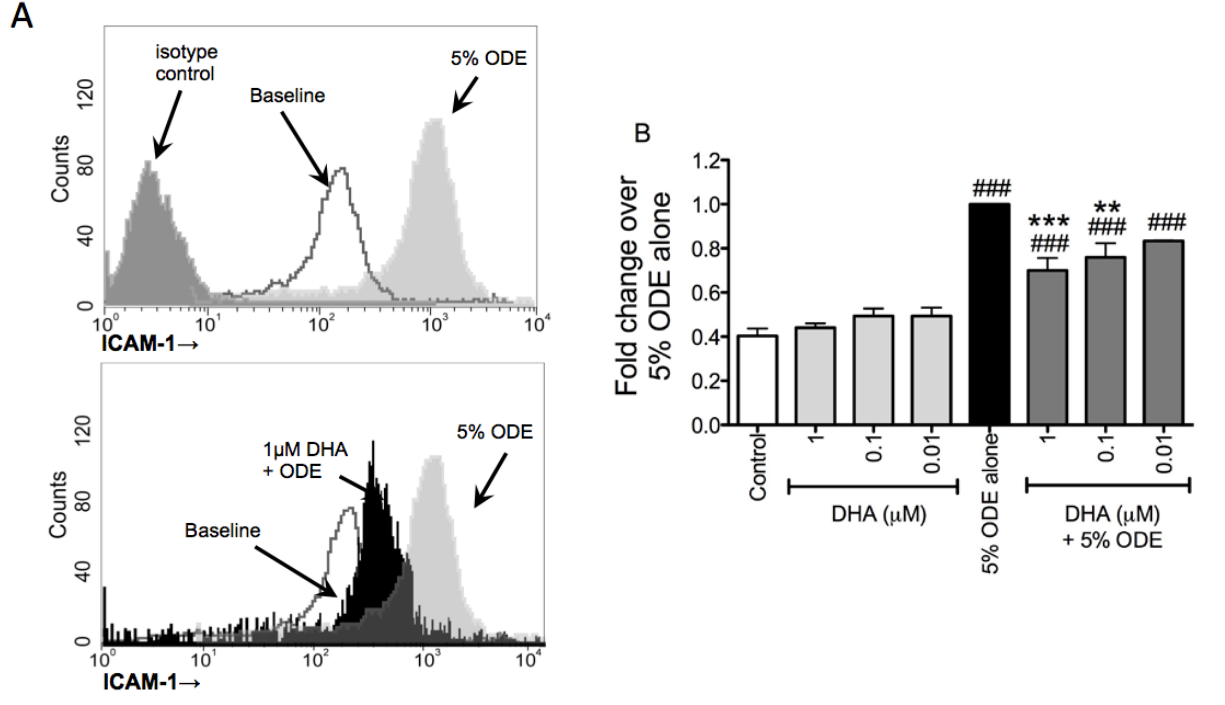
Figure 5. DHA pretreatment reduces ODE-induced ICAM-1 expression on bronchial epithelial cells. Beas-2B cells were pretreated with 0. 0.01, 0.1, or 1 μM DHA for 1 h prior to stimulation with 5% ODE for 24 h. Following 24 h ODE treatment, cells were stained for ICAM-1 expression and flow cytometry was performed to delineate the ICAM-1 surface expression levels on the bronchial epithelial cells. ( A ) Gated histogram of representative experiment indicating the intensity of PE staining on bronchial epithelial cells with and without DHA and ODE treatments; ( B ) Bar graph summarizing three separate experiments indicating the fold change of mean fluorescent intensities over 5% ODE alone. Data were calculated from 10,000 gated events for each treatment group within each experiment following normalization with isotype controls. ### p ≤ 0.001 vs. control; ** p ≤ 0.01 vs. 5% ODE alone; *** p ≤ 0.001 vs. 5% ODE